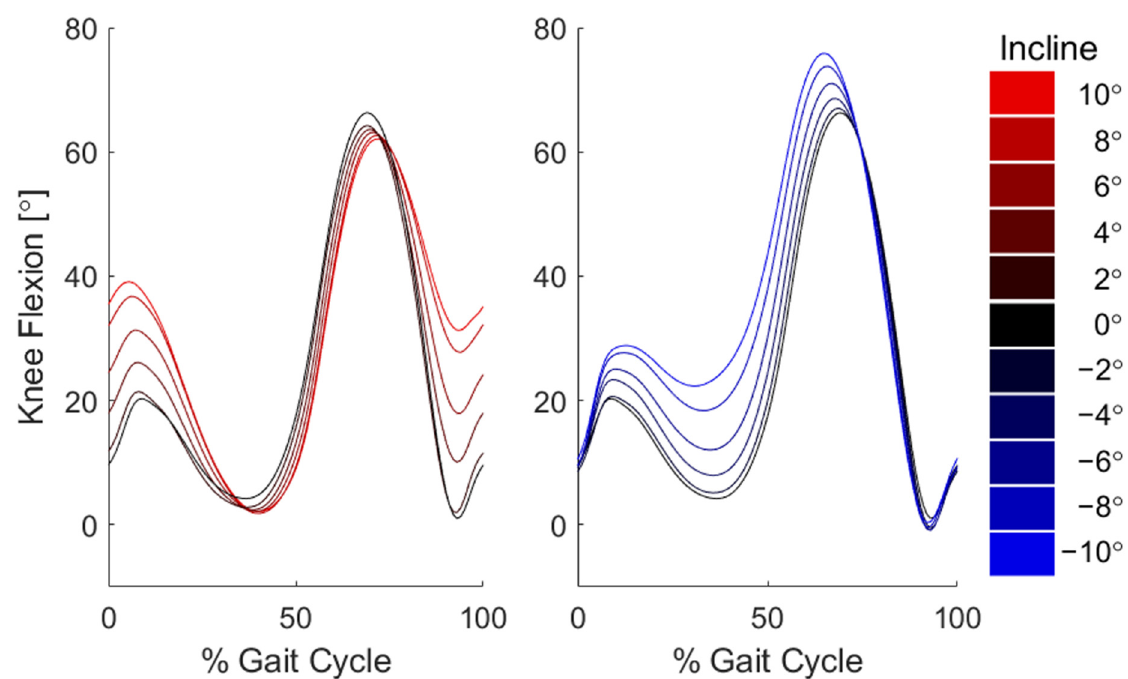
Figure A3. Mean knee flexion angles from each slope bin.